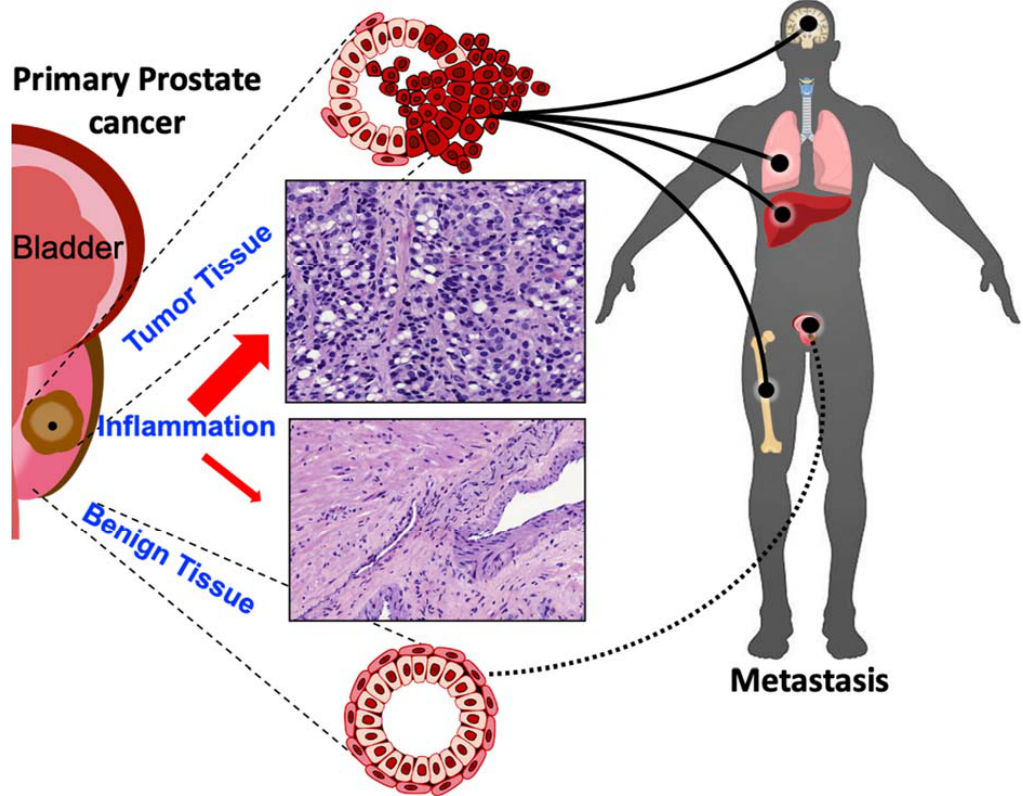
Figure 1. The Case of Inflammation within the Primary Prostate Tumors. Schema of normal prostate and corresponding / adjacent prostate tumor from biopsies in the patient. H&E staining indicating areas of inflammatory cell infiltration from the primary prostate cancer. Inflammation as a histopathological feature on the local prostate adenocarcinoma that remains organ-confined is not explicitly defined and its contribution in the context of navigating the aggressive behavior of prostate cancer to bone metastasis is even more poorly understood. We propose that inflammation in the primary tumor microenvironment can navigate the metastatic journey beyond the prostate including the liver, brain, lung, and bone. Di ff erentiating prostate inflammation from cancer development early is critical to reducing overtreatment and overcoming therapeutic